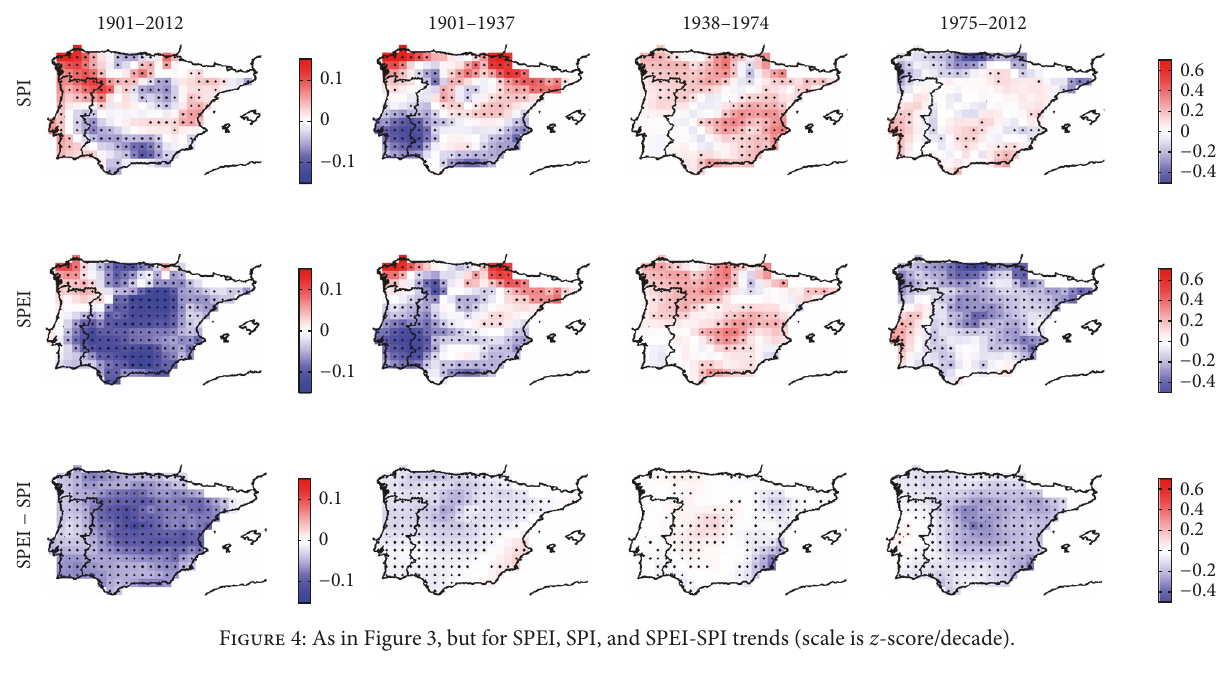
Figure 4: As in Figure 3, but for SPEI, SPI, and SPEI-SPI trends (scale is z -score/decade).